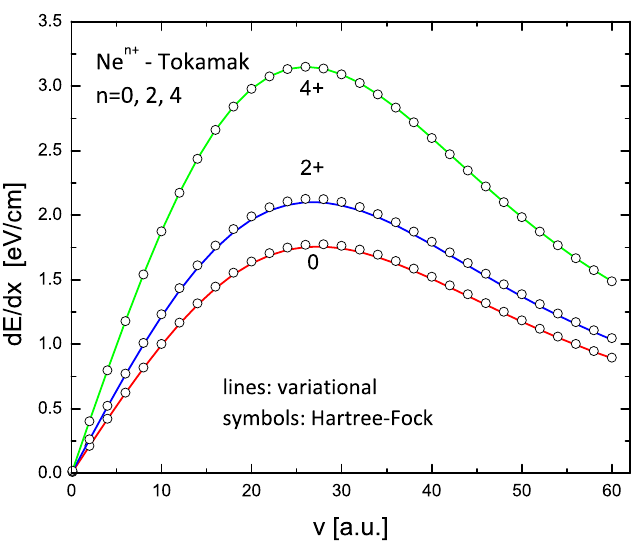
Figure 10. Same as in Figure 9 but for Ne 0 , Ne 2 + , and Ne 4 +